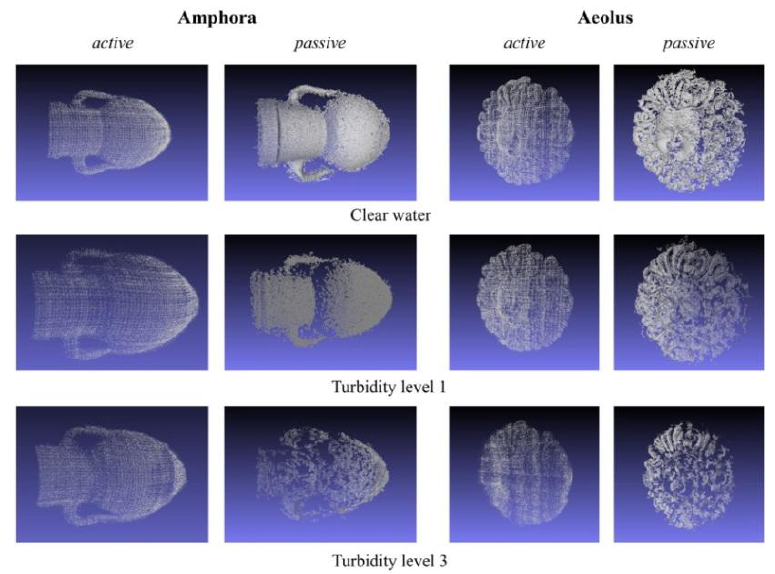
Figure 10. Point clouds obtained after editing procedure in different environment conditions for both active and passive